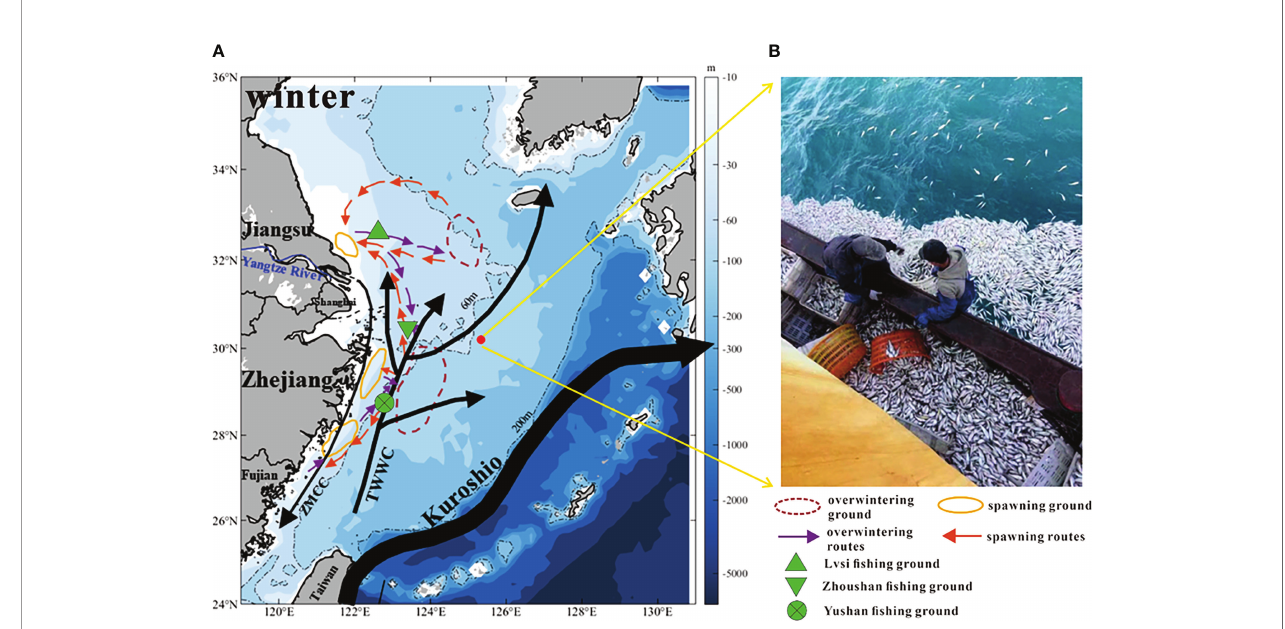
FIGURE 1 | (A) The East China Sea circulation in winter (TWWC: Taiwan Warm Current; ZMCC: Zhe-Min Coastal Current) and migration grounds and routes of small yellow croaker. The circulation is redrawn based on Liu et al. (2021b); the migration grounds and routes of small yellow croakers are after Ren et al. (2020). (B) The event: a large number of small yellow croaker fl oated on the sea surface around the fi shing